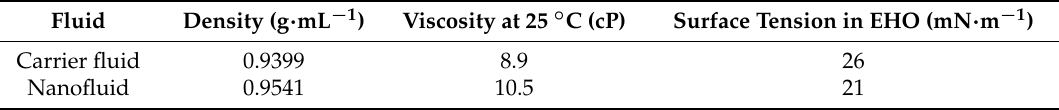
Table 2. Density and viscosity of the carrier fluid and nanofluid at 25 ◦ C. The surface tension after their inclusion in the EHO is also